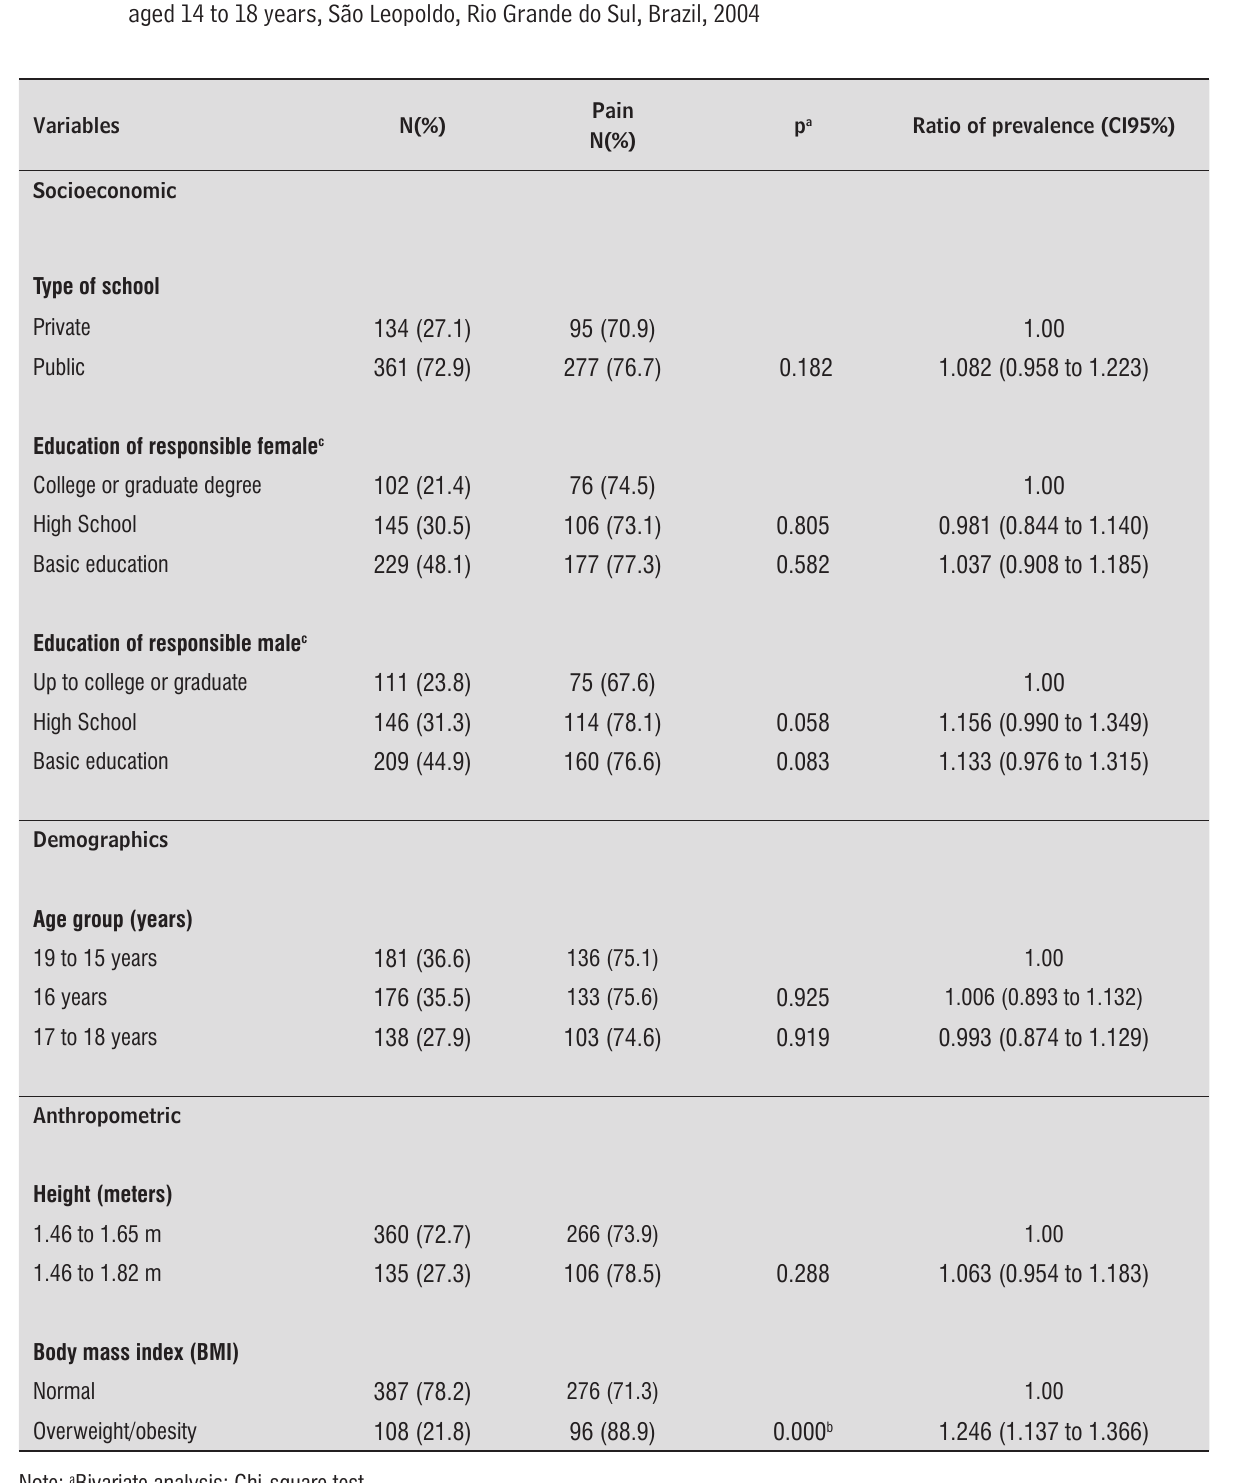
Table 1 - Prevalence of back pain and socioeconomic, demographic and anthropometric variables in female students aged 14 to 18 years, São Leopoldo, Rio Grande do Sul, Brazil,